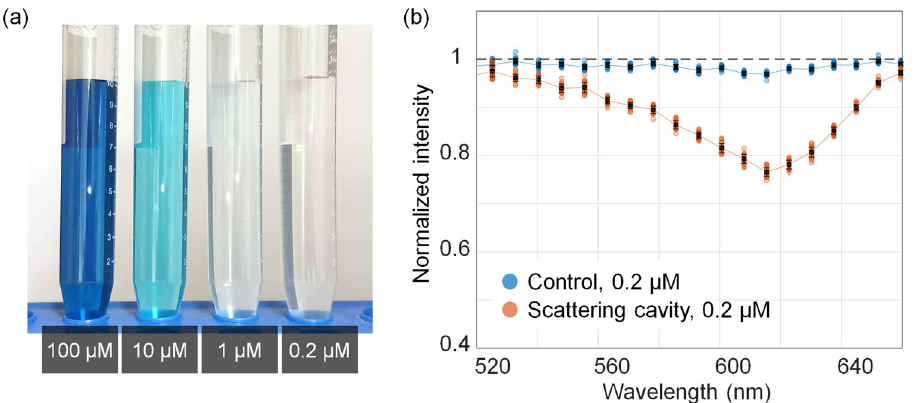
Figure 2. ( a ) Photographs of malachite green aqueous solutions at 100, 10, 1.0, and 0.2 µM. ( b ) Comparison for the normalized absorption spectra of 0.2 µM malachite green aqueous solution measured with the conventional method and the proposed method. Error bars, standard deviations.